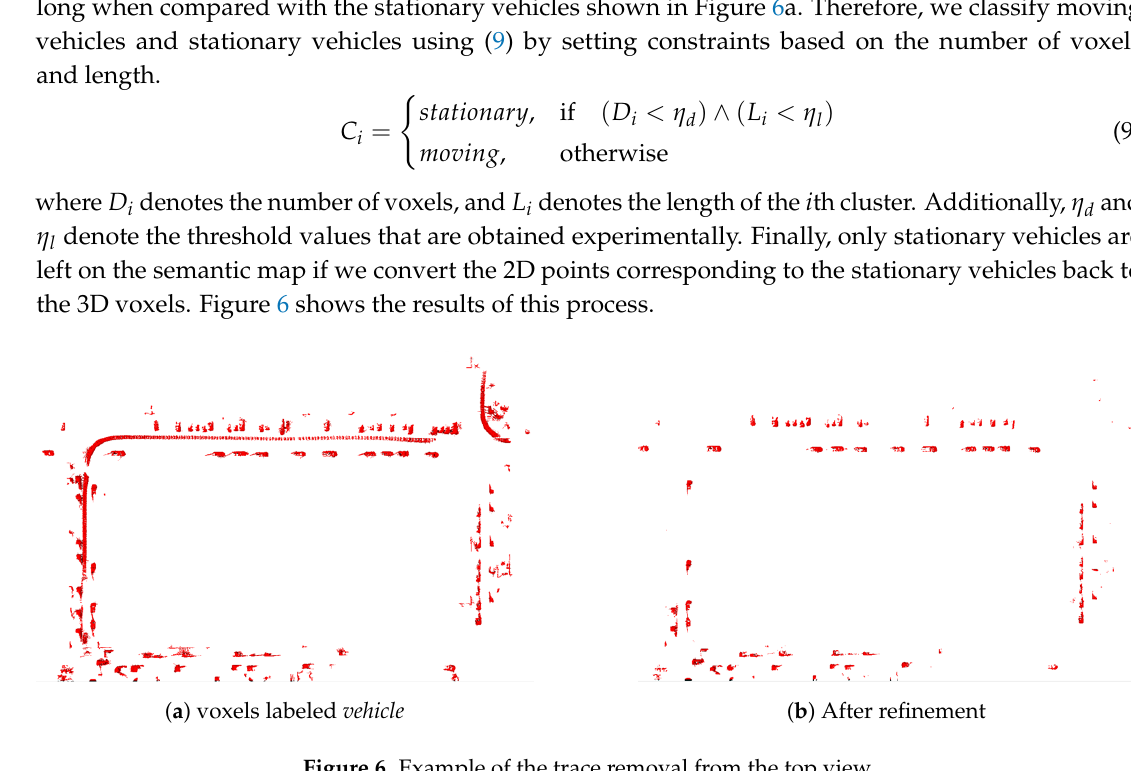
Figure 6. Example of the trace removal from the top